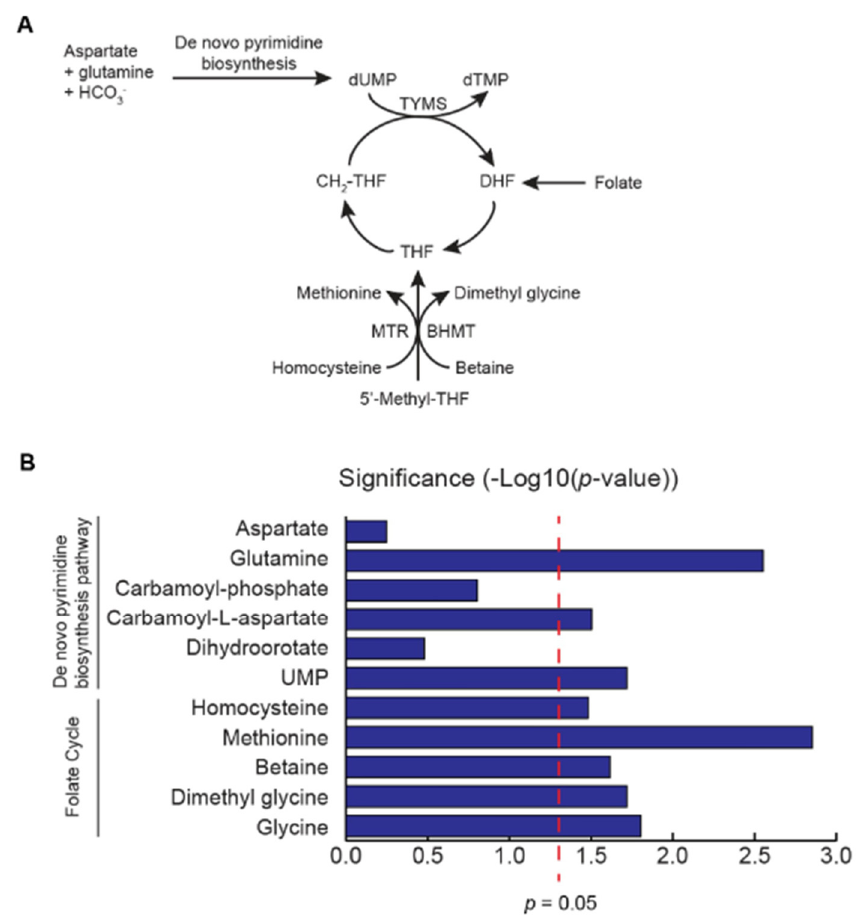
Figure 2. Metabolomics analysis identifies upregulation of metabolites involved in de novo pyrimidine biosynthesis and downregulation of metabolites necessary to drive the folate cycle. ( A ). Diagram of the de novo pyrimidine biosynthesis pathway and the folate cycle. ( B ). Alterations in metabolites associated with folate cycle and de novo pyrimidine synthesis in AA tumors ( n = 50) in a previously published metabolomics dataset (3). X-axis represents the degree of significance of altered metabolites in AA tumors vs benign adjacent tissue. Bars extending the right of the red dotted line indicates the statistical significance of the metabolic alterations ( p ≤ 0.05). The Wilcoxon matched pairs signed rank test was used to calculate statistical